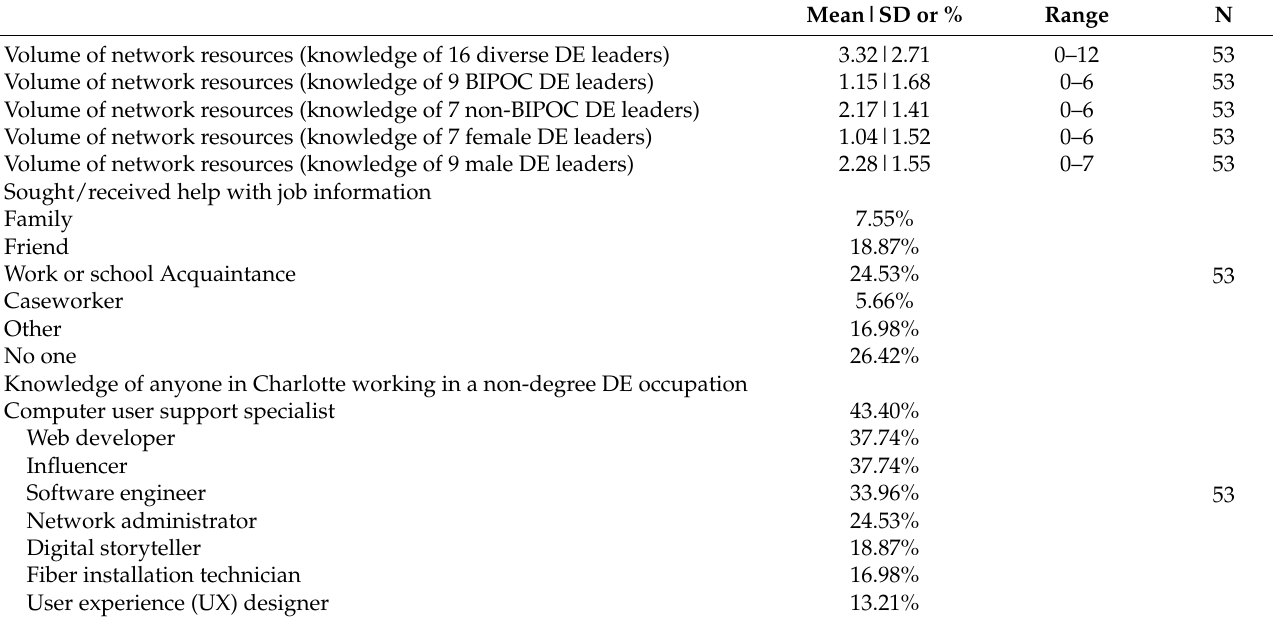
Table 6. Measures of Digital Economy (DE) Social